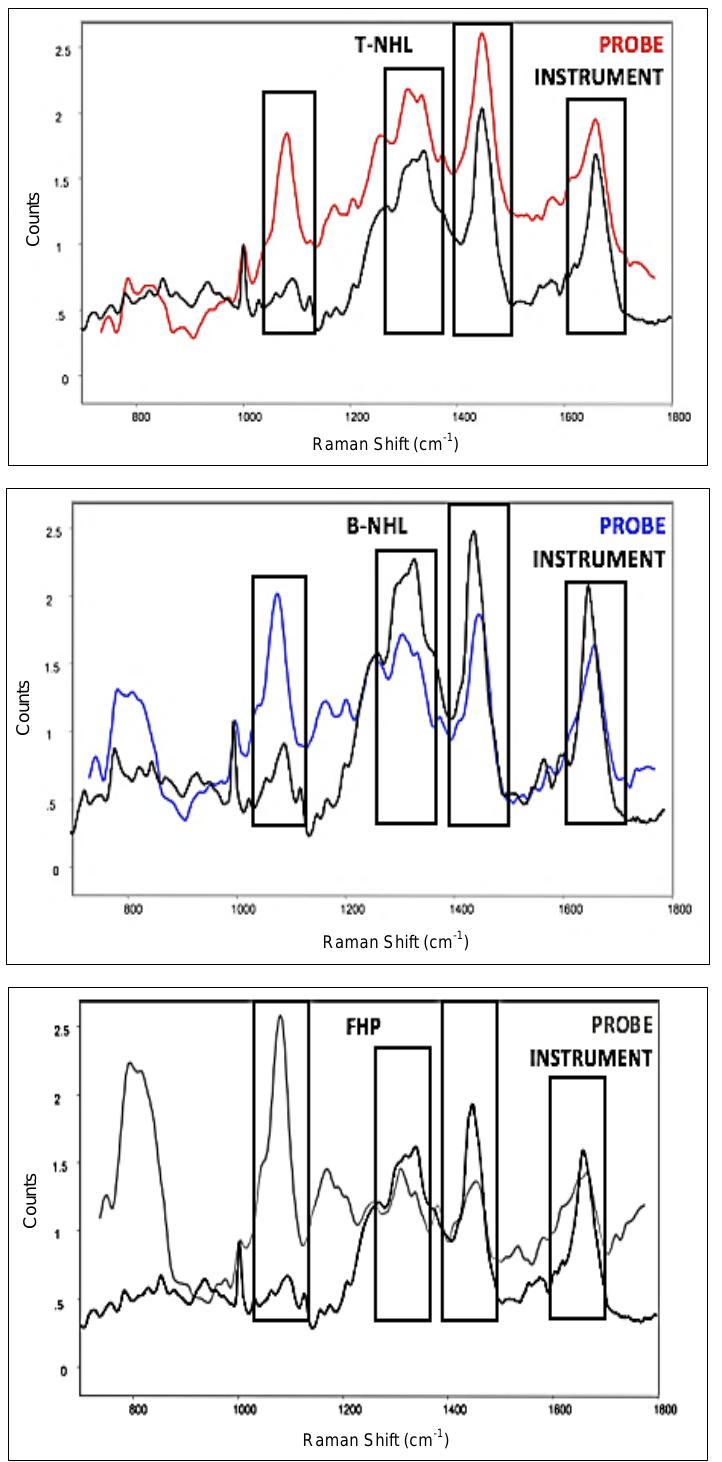
Figure 2. Comparison of averaged Raman spectroscopy (RS) peaks of T-NHL, B-NHL, and FHP from RESpect probe and RS instrument. Primary peaks (1095, 1337, 1448, and 1659 cm -1 ) from the two RS sources are